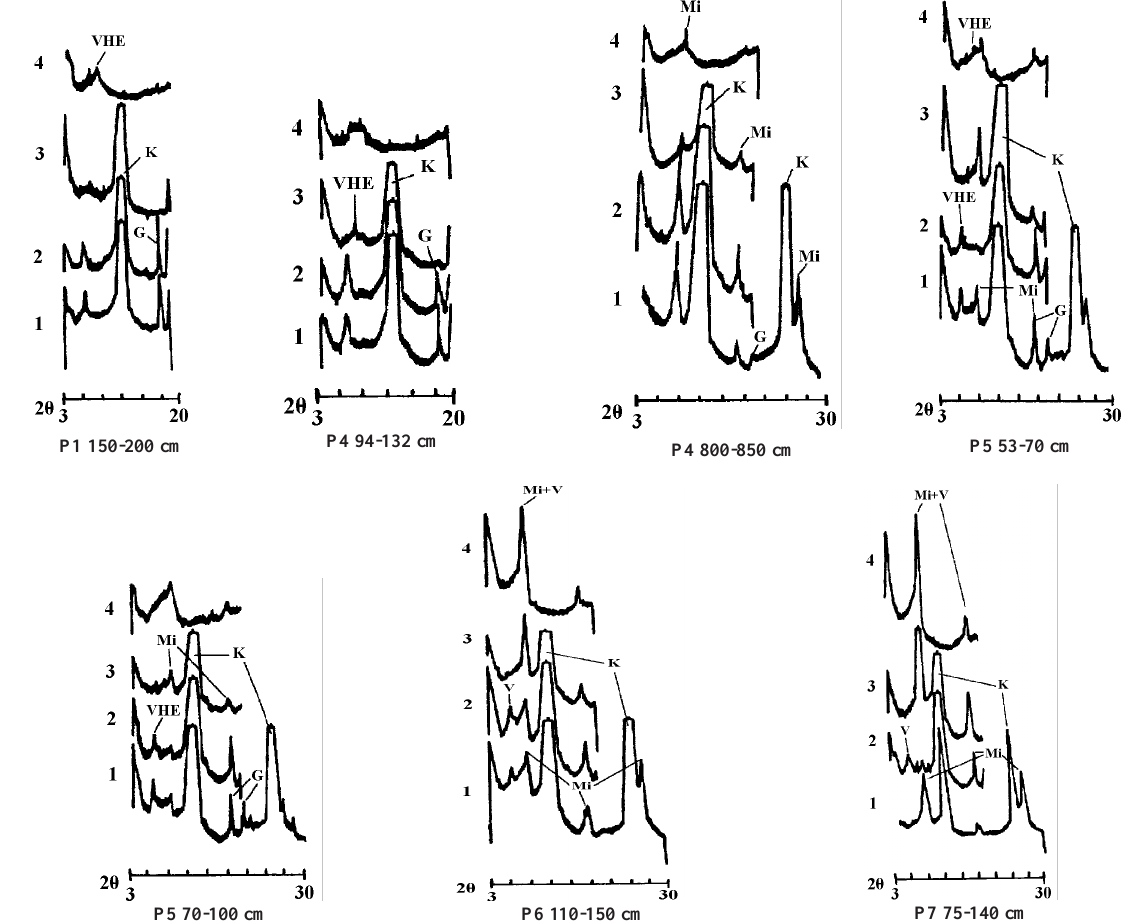
Figura 2. Difratogramas da fração argila dos perfis estudados. Tratamentos: (1) K + 25 o C; (2) Mg 2+ 25 o C, glicolada; (3) K + , 350 o C; (4) K + 550 o C. Mi: mica (ilita); V: vermiculita; VHE (vermiculita com hidróxi entrecamadas); K: caulinita; G: